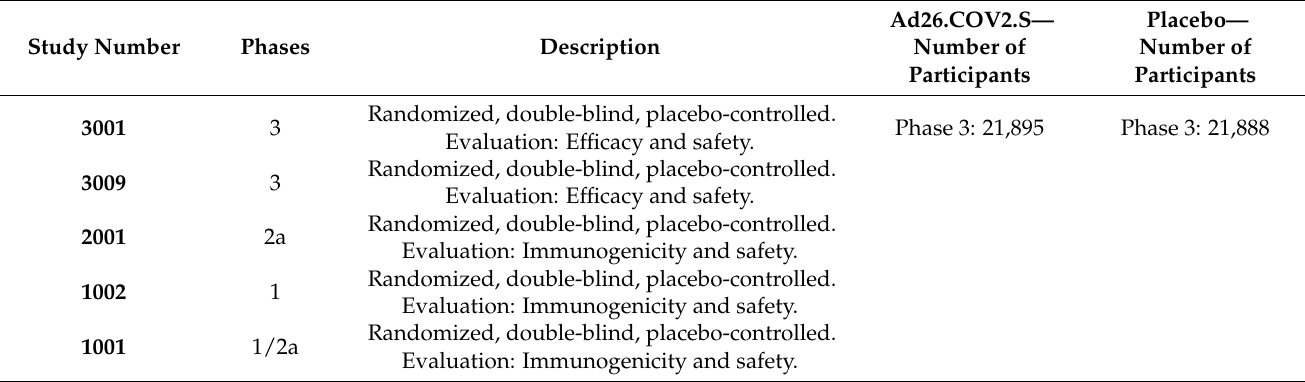
Table 5. Janssen/Johnson & Johnson COVID-19 Vaccine—Study Description